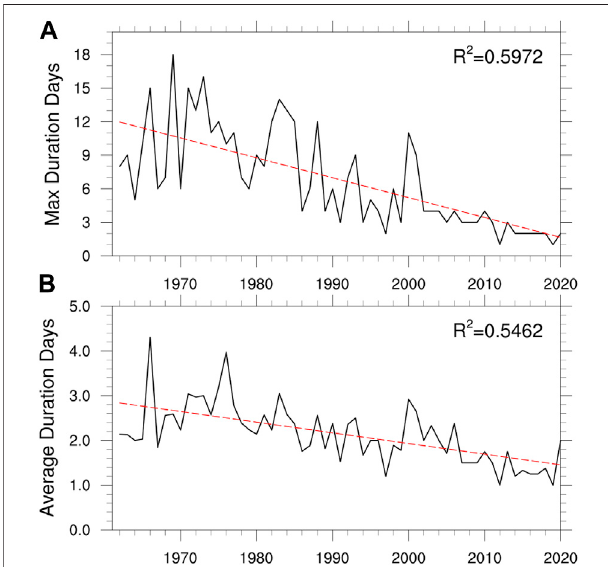
FIGURE 3| Time evolution of (A) annual longest duration and (B) annual average duration of sand-dust processes from 1961 to 2020. The red dotted line denotes the linear trend.